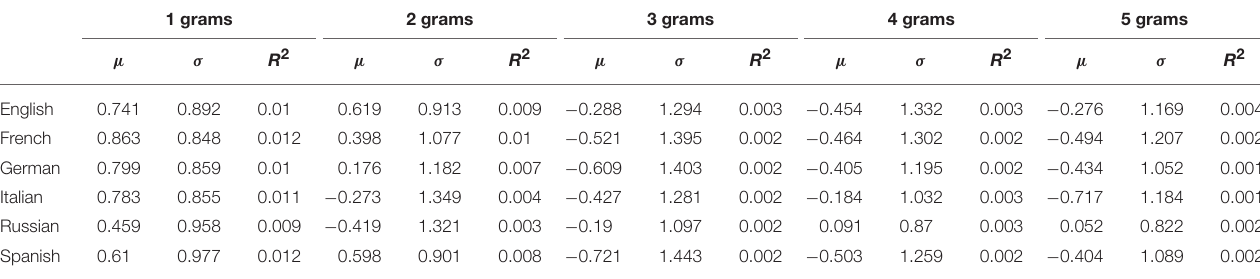
TABLE 3 | Fit parameters for rank entropy for different languages.